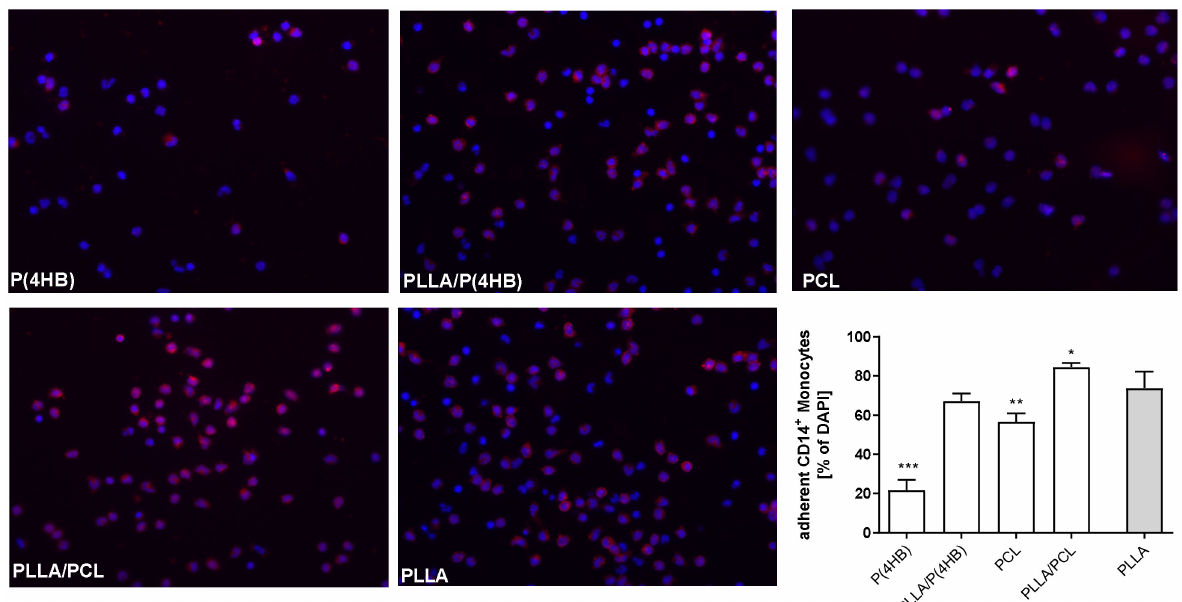
Figure 4. Monocyte adhesion and activation on polymer surfaces. Human peripheral blood mononuclear cells (PBMCs) were isolated from an in-line filter system for leukocyte filtration. Subsequently, PBMCs were exposed to the indicated polymer surfaces for 3 h. After incubation, adherent PBMCs were stained for DAPI (nucleus) and CD14, which is expressed by monocytes. Representative images of 5 independent experiments are shown. Images were quantified using ImageJ software. Bars show mean ± SD of adherent monocytes compared to the PLLA surface with * p < 0.05, ** p < 0.01 and *** p <